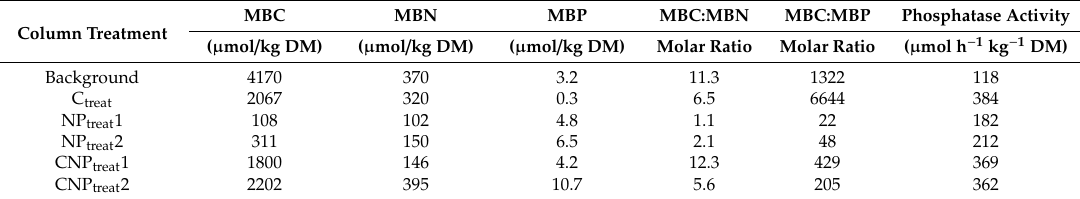
Table 2. Sediment microbial biomass CNP and phosphatase enzyme activity determined on destructive sampling of the columns after the treatments. To show background microbial conditions, the prepared packing sediment was used after storage at 5 ◦ C for the experimental